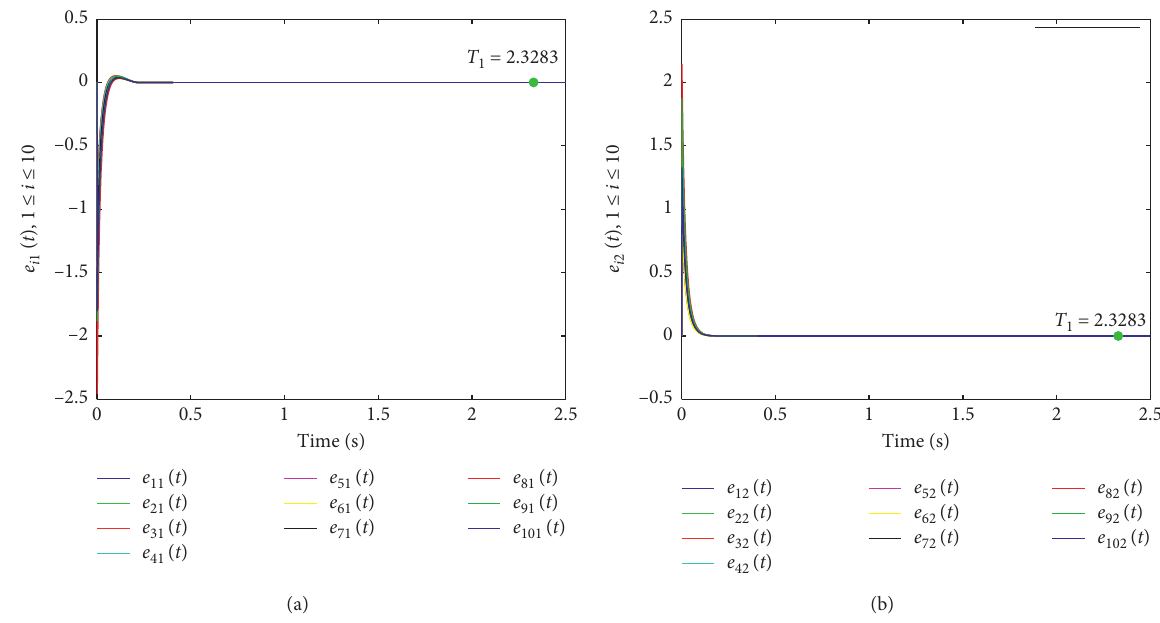
Figure 3: The synchronization errors between systems (35) and (36) by controller (17). (a) e